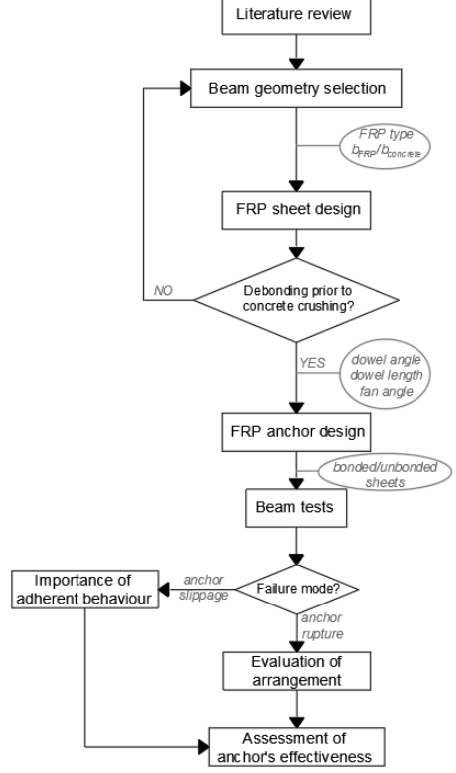
Figure 1. Methodological flow chart.